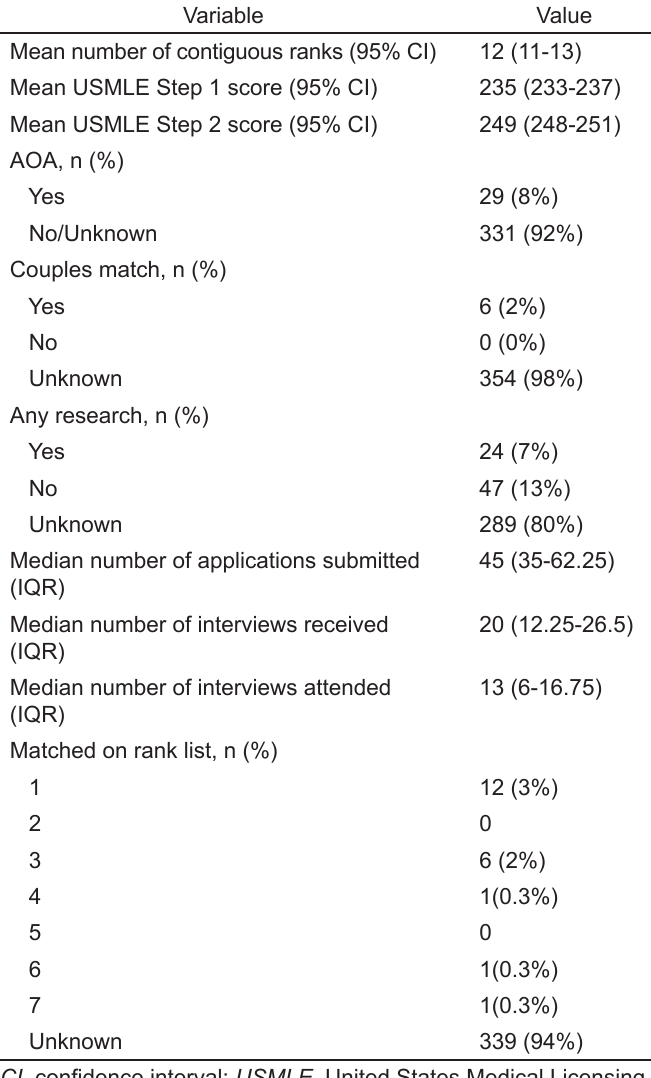
Table 1. Summary of Student Doctor Network data from 2014, 2016, and 2018.